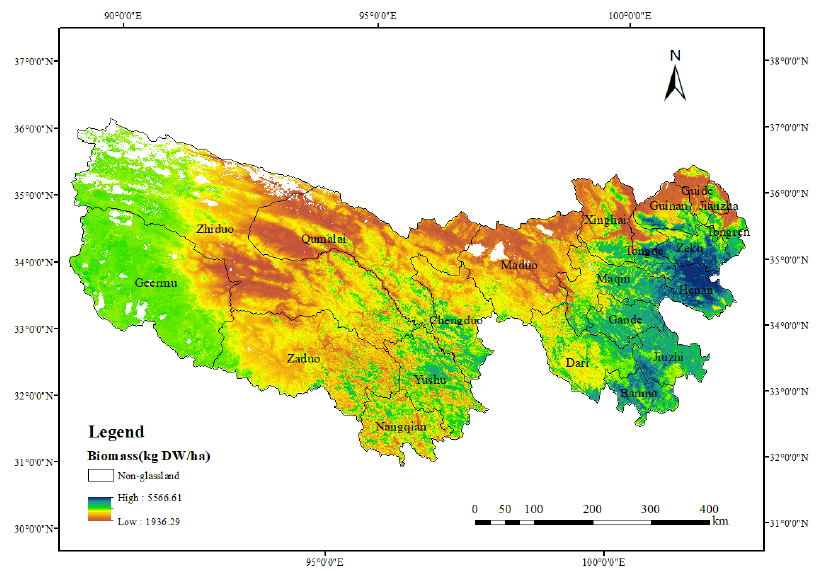
Figure 6. Distribution map of average grassland AGB in the TRHR from 2005 to 2015. Figure 5. Distribution map of average grassland AGB in the TRHR from 2005 to